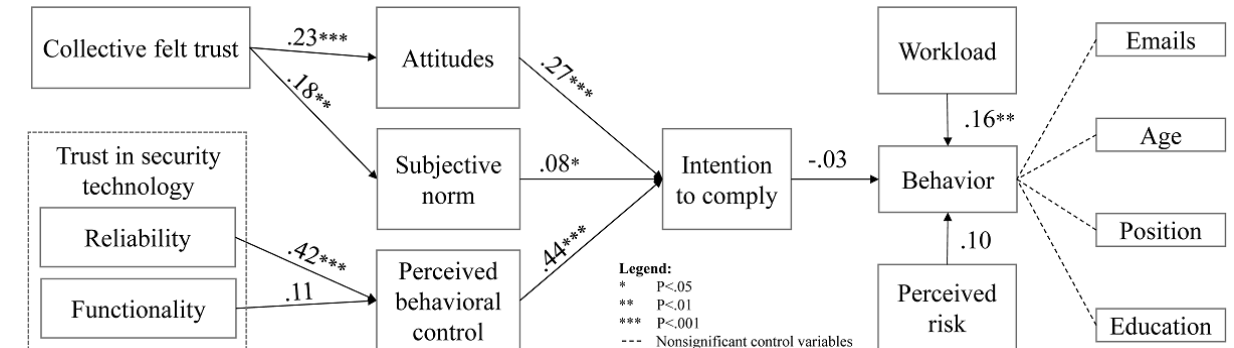
Figure 2. Results of structural equation